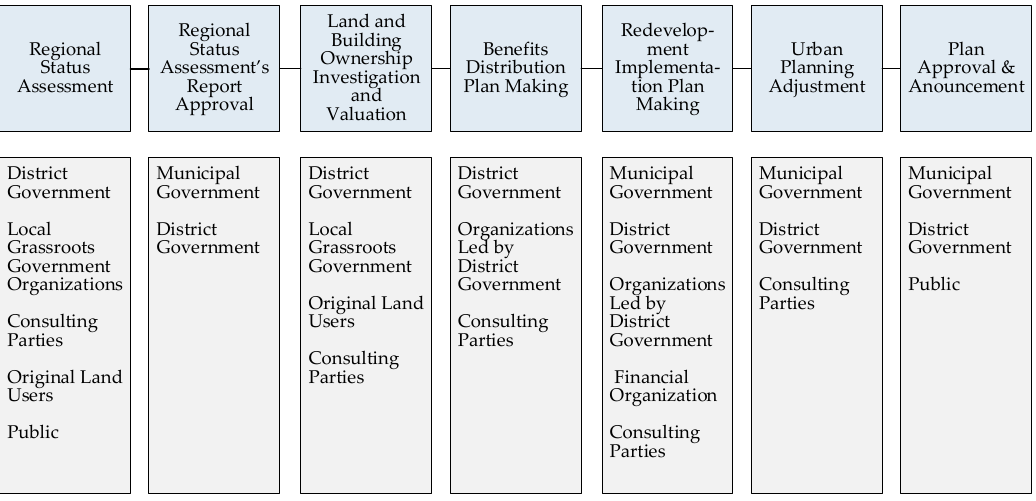
Figure 2. The simplified decision-making process of ILR and the stakeholder groups involved in each step of the process in Shanghai, China (by the authors).